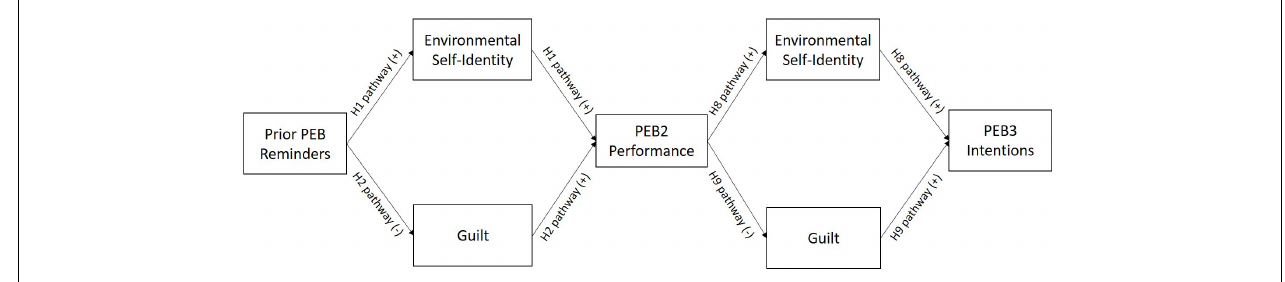
FIGURE 1 | Theoretical spillover model. PEB, pro-environmental behavior. Only adjacent direct paths are shown in figure, though all downstream direct and indirect paths are theorized in the model.